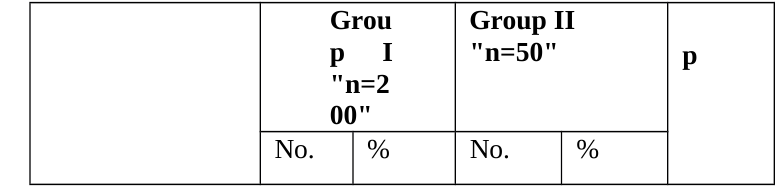
Table (6): Comparison between the two studied groups regarding global acne assessment score at 0, 2, 4 and 6